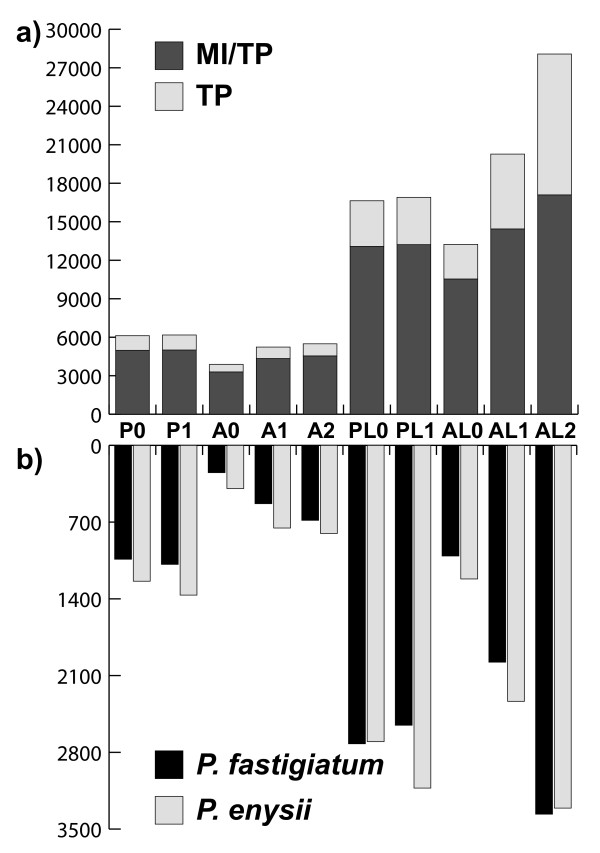
a) Heatmap showing percentages of overlap in numbers of DEGs between different analyses using different sets of reference genes as well as between tag profiling and microarray analyses. Percentages between different reference sets ranged from 44% to 90% indicating that the choice of the reference set greatly affected what genes were being identified as differentially expressed. Percentages of overlap between microarray analysis and tag profiling were higher with the P. fastigiatum reference sets than with the A. thaliana reference sets in both species (49-60% vs. 21-46%) This indicates that mapping tags to P. fastigiatum is preferable to mapping tags to A. thaliana. All overlaps between microarray and tag profiling analyses were statistically significant (denoted by stars). b) Heatmap showing percentages of contradictory results obtained using different sets of reference genes and between tag profiling and microarrays (= percentage of genes up-regulated in P. enysii with one method and P. fastigiatum with another method). Disagreements between different tag profiling datasets ranged from 0% to 11% indicating the detection of false positives with almost all approaches. All disagreements between tag profiling and microarray analyses were not statistically significant. Also, disagreements did not differ between P. fastigiatum and A. thaliana reference sets (6-12% vs 0-14%). For abbreviations of different sets of reference genes see Aditional file 3 and for calculation of percentages and statistical significance see methods.